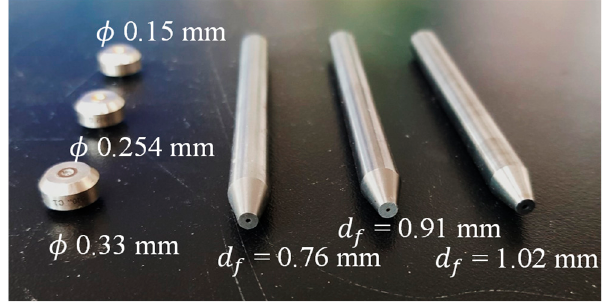
Figure 3. Orifices and focuses. Table 2. Abrasive waterjet operation conditions and experimental cases. Table 2. Abrasive waterjet operation conditions and experimental cases. Orifice Diameter